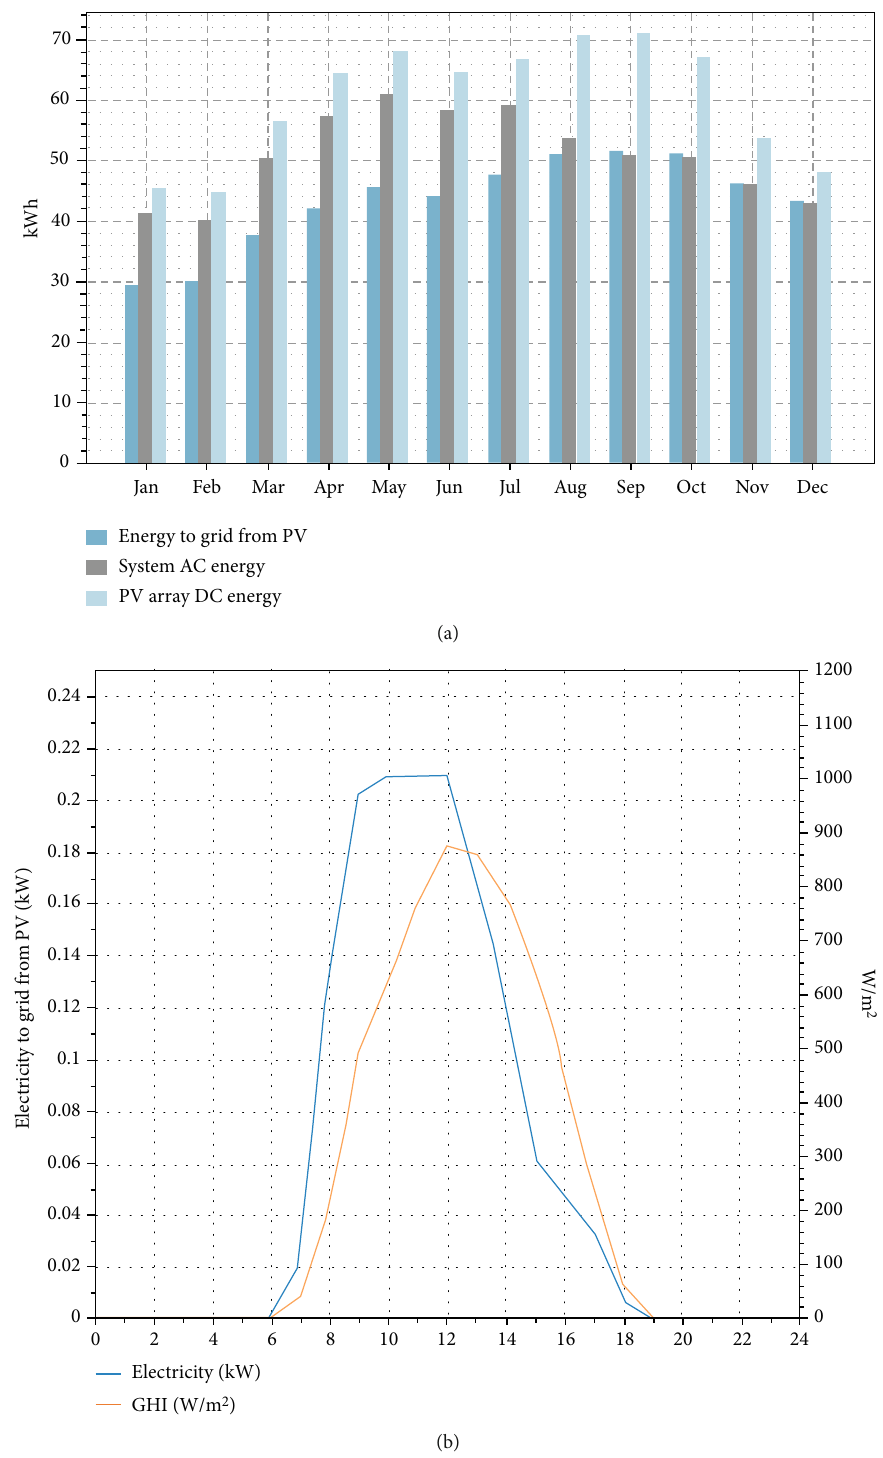
Figure 3: (a) Monthly energy production. (b) Average annual energy production vs.